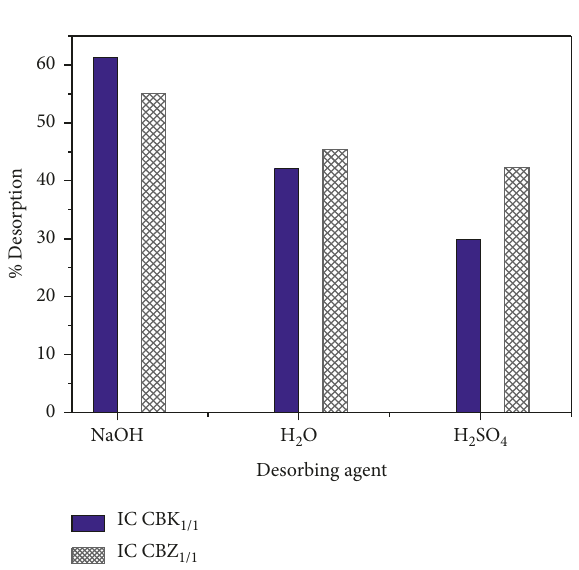
Figure 17: Percentage of desorption obtained onto different ACs after adsorption of IC. Experimental conditions: 50mg; t � 80min; v � 200rpm; V � 10mL, at room